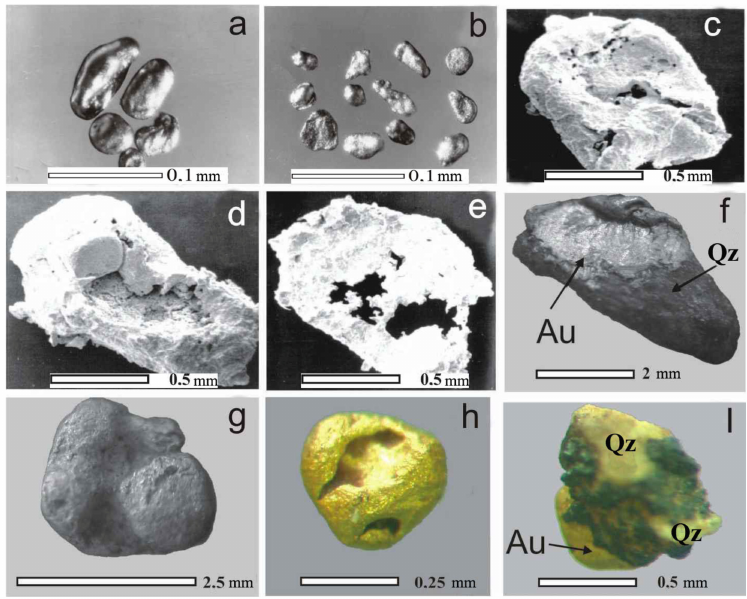
Figure 18. Gold particles with signs of wind-worn processing of platform areas, as well as on the territory of Tuva and Mongolia: ( a , b ) Russian [41]; ( c – e ) African [37]; ( f , g ) Tuva (TIIDNR); ( h , i ) Mongolia (IGM SB